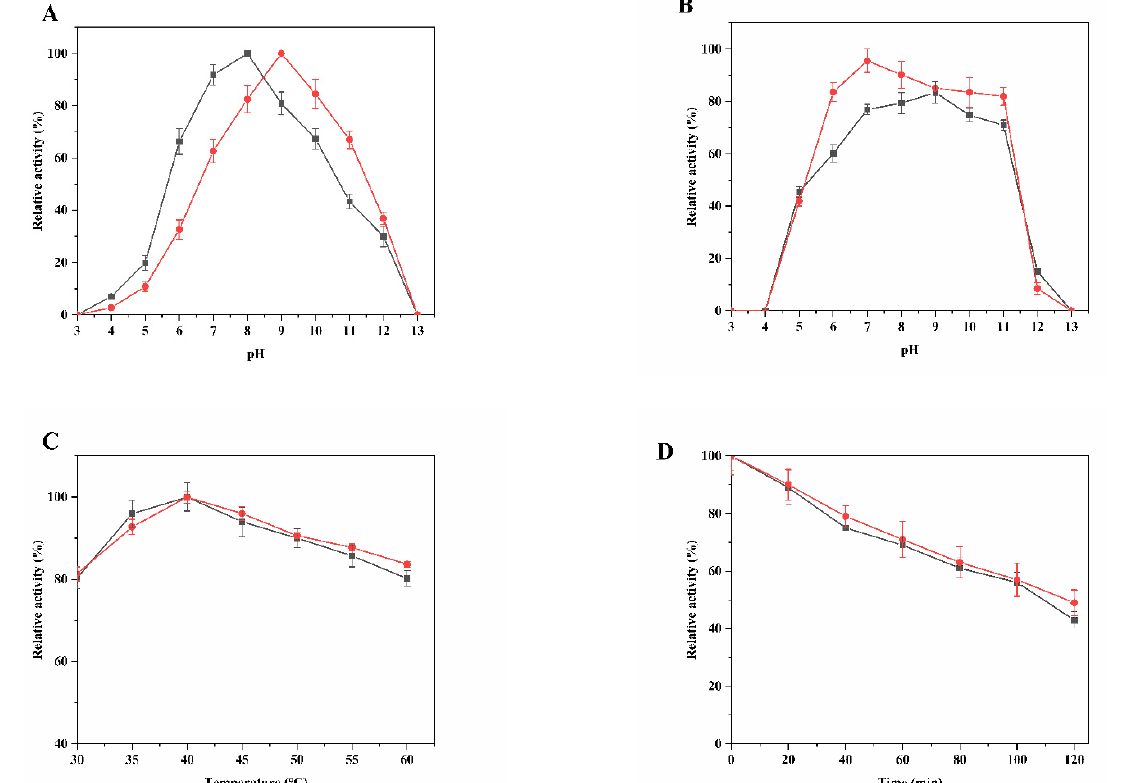
Figure 3. The temperature and pH effects on BLASNase: ( A ) relative activity at various pH; ( B ) residual activity after incubation at 4 °C for 24 h; ( C ) relative activity at various temperatures; ( D ) residual activity after incubation at 60 °C during 120 min. Black squares, wild-type; Redcircles, and mutant ILRAC. Table 1. Catalytic properties of wild-type and mutant ILRAC.